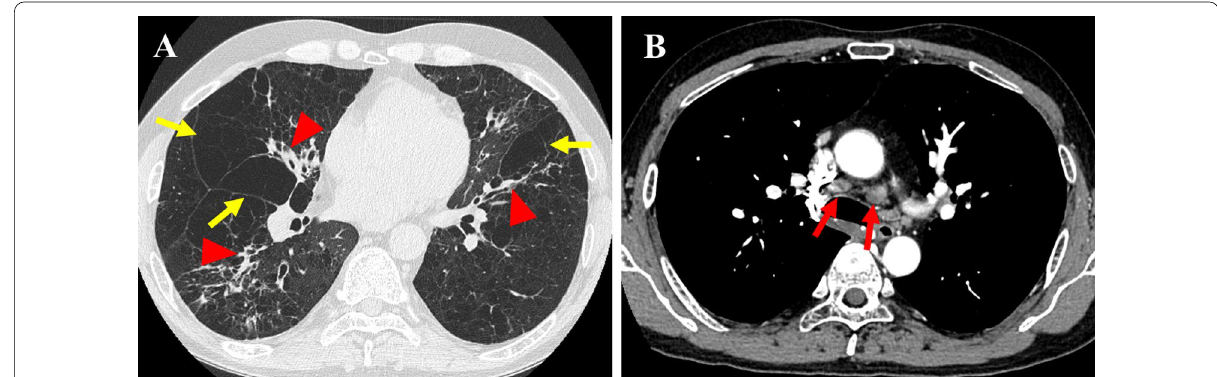
Fig. 1 Preoperative chest computed tomography revealed thickening of the bronchovascular bundles (red arow head), ground-glass opacities, scattered cystic lesions (yellow arrow) ( A ), and slight enlargement of the mediastinal lymph nodes (red arrow) ( B )